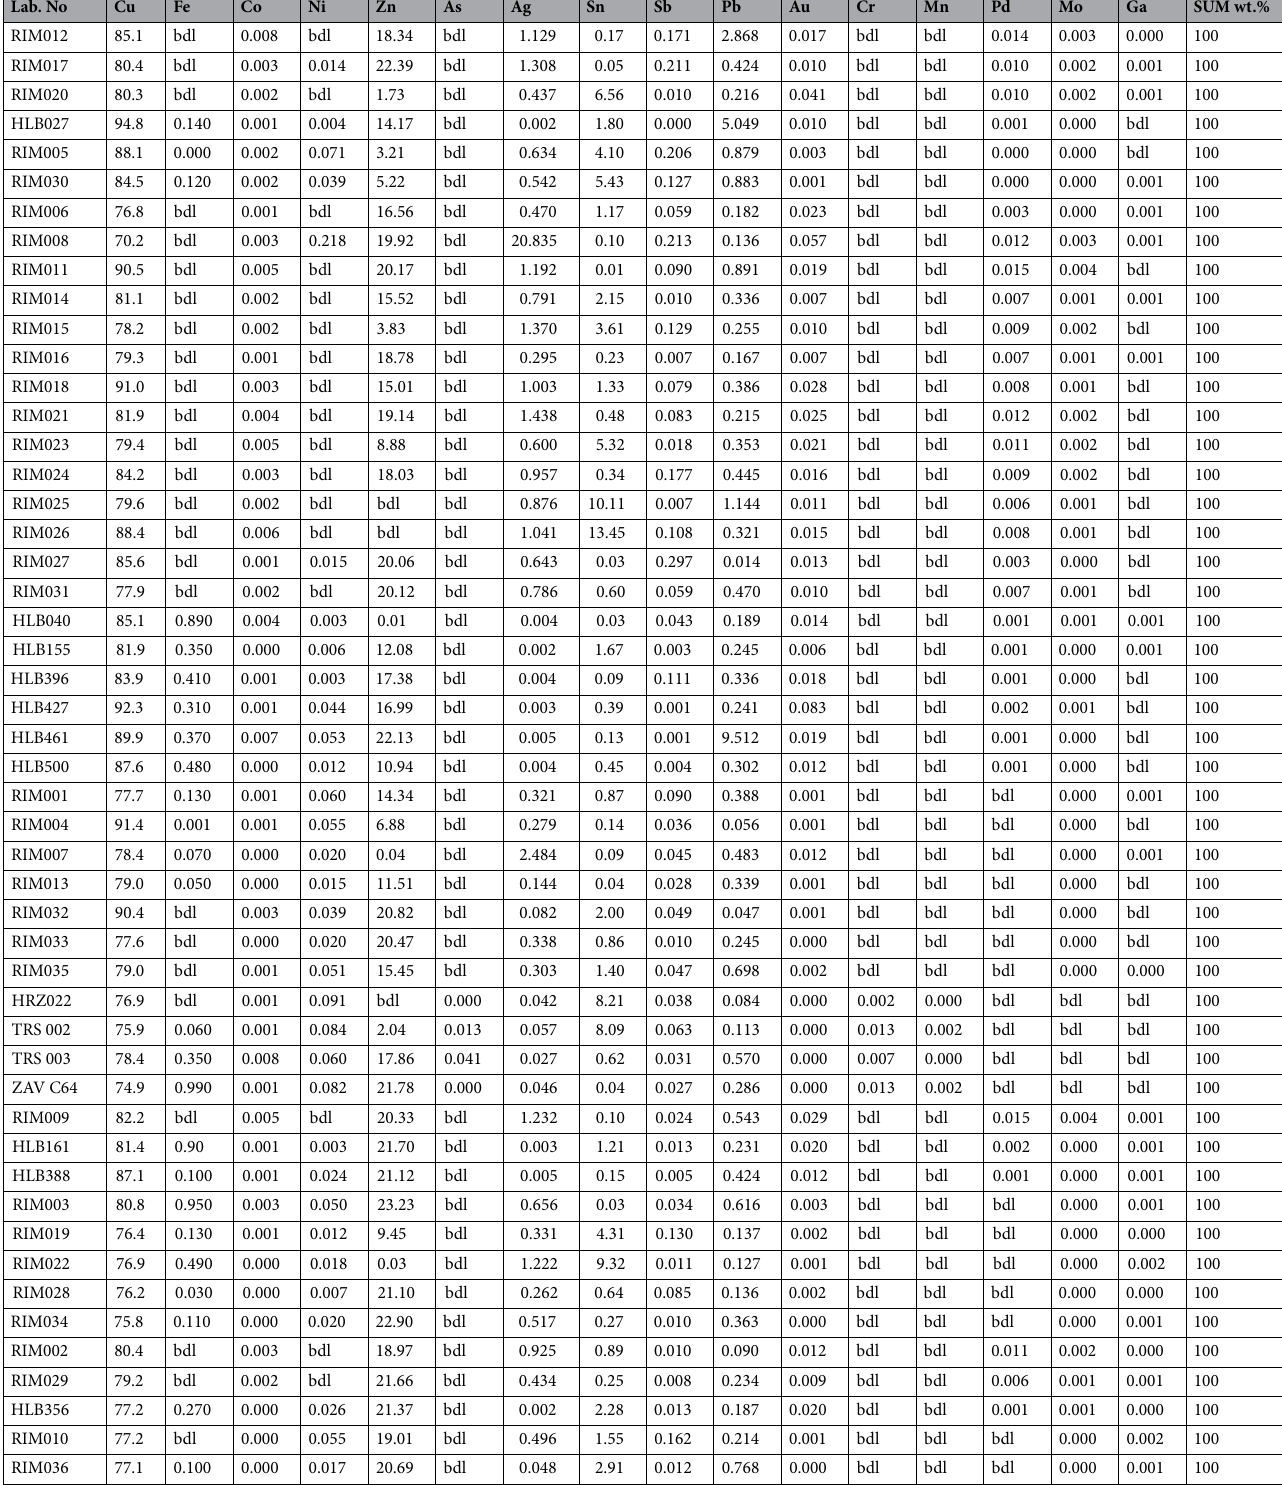
Table 3. Chemical composition in wt.% of the analysed